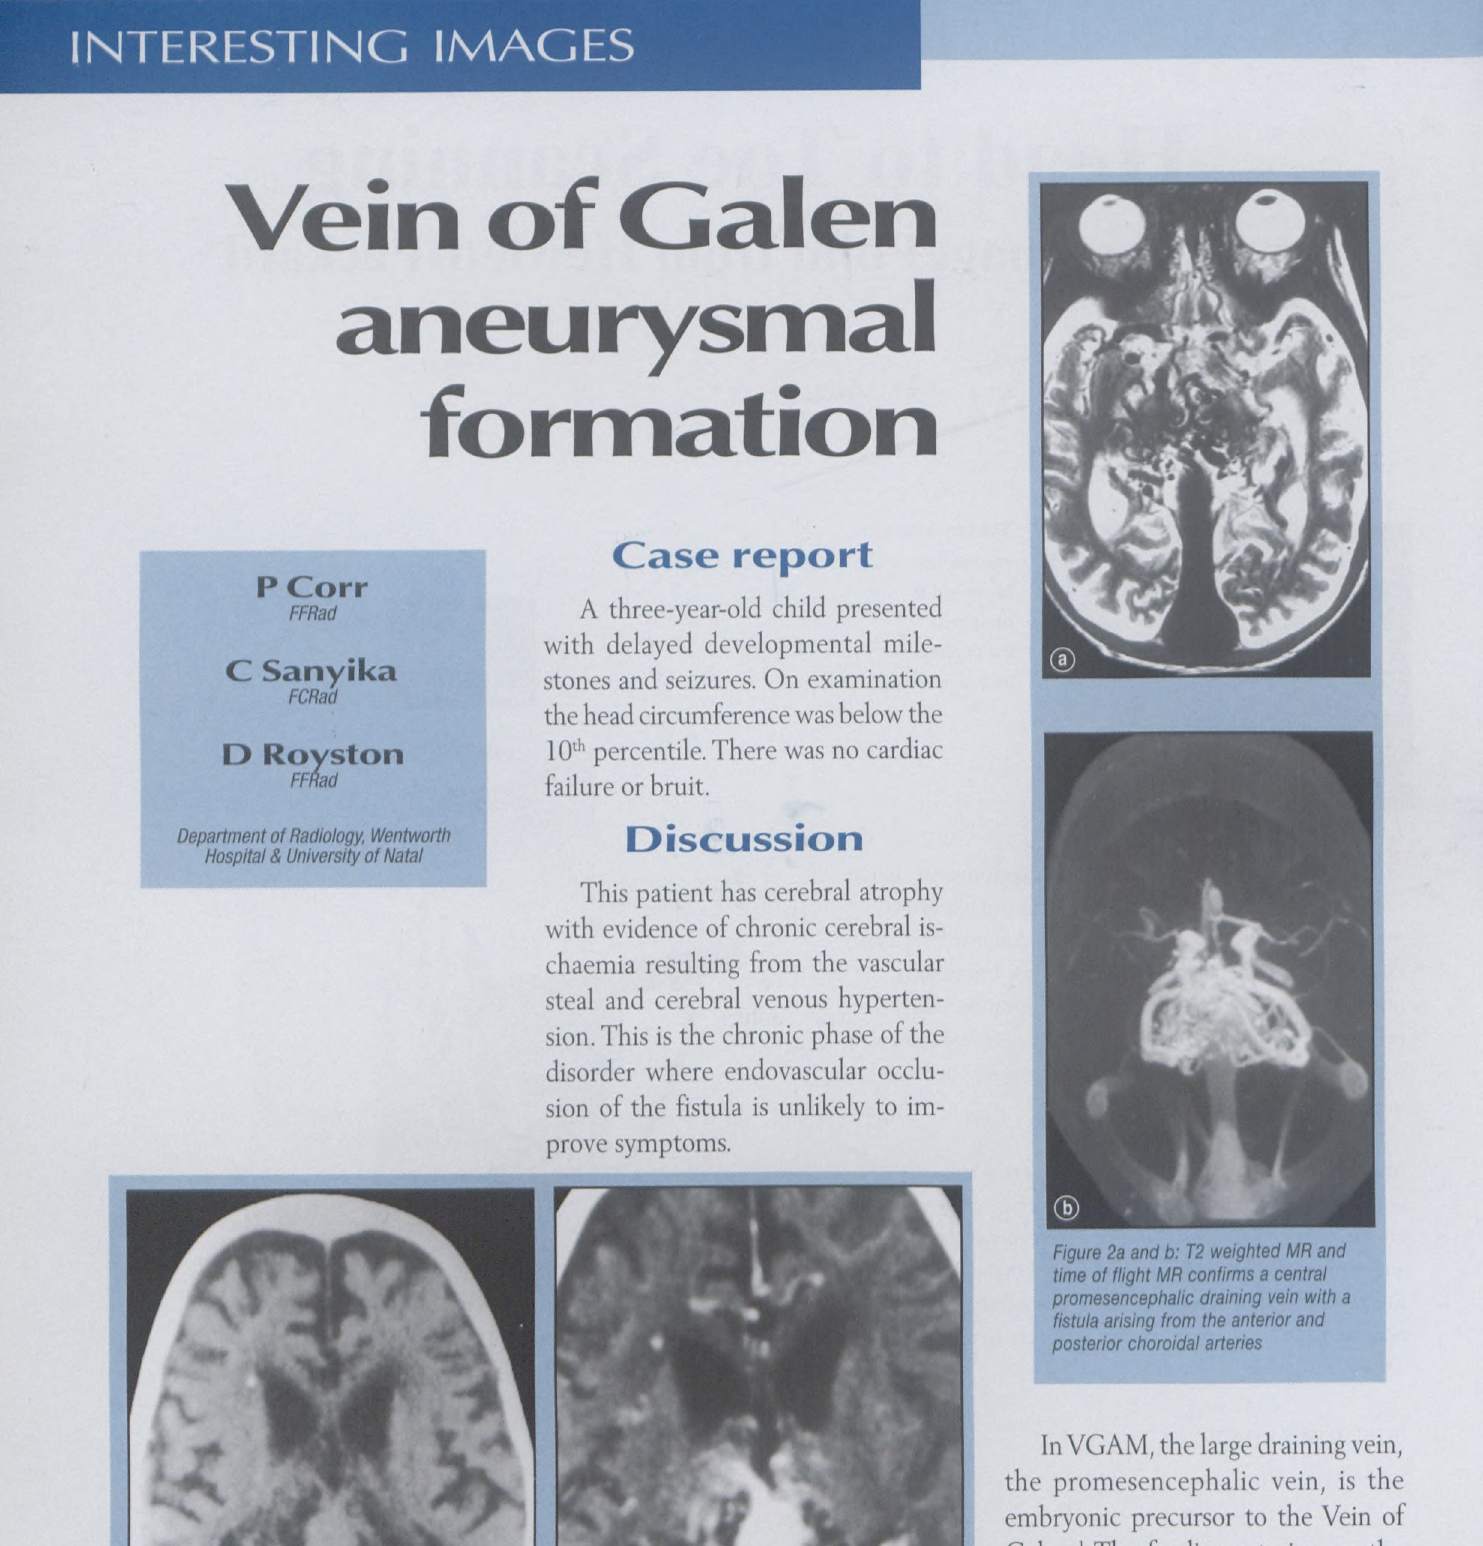
In VGAM, the large draining vein, the promesencephalic vein, is the embryonic precursor to the Vein of Galen. I The feeding arteries are the choroidal vessels and subependymal vessels from the posterior Circle of Willis. This disorder must be differ- entiated from the Vein of Galen mal- formation, in which the Vein of Galen is